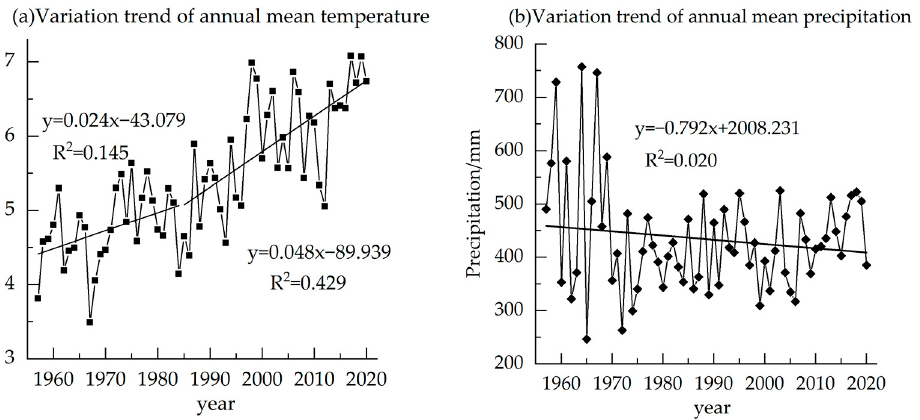
Figure 8. Variation trend of annual mean temperature and annual mean precipitation in the study area from 1957 to 2020.